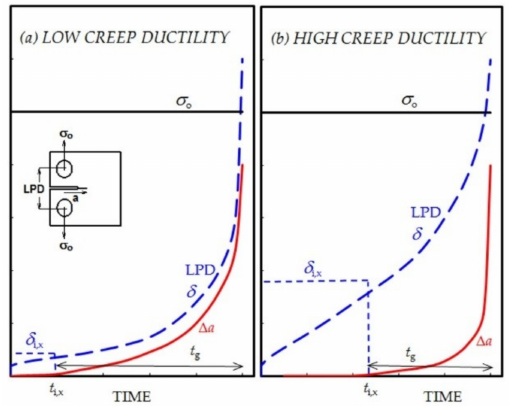
Figure 8. Crack incubation and crack growth contributions to lifetime of components with pre-existing defect subject to steady loading ( σ o ) at high temperature, for steels with: ( a ) Low creep ductility, and ( b ) high creep ductility